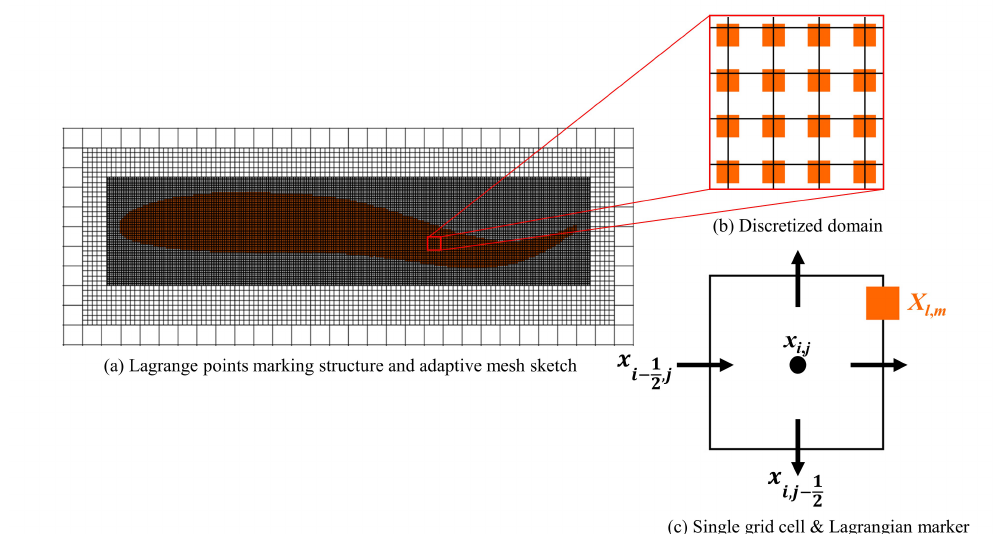
Figure 2. ( a ) Lagrange points marking structure and adaptive mesh sketch. ( b ) Numerical discretiza- tion of the Lagrangian markers ( (cid:4) , orange). ( c ) A single Cartesian grid cell on which the components of the velocity field U b are approximated on the cell faces ( −→ , black), and the Lagrangian quan- tities are approximated on the marker point ( (cid:4) , orange), which can be arbitrarily placed on the Eulerian